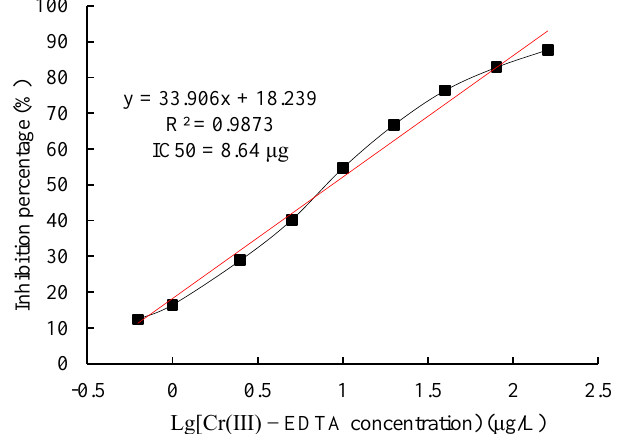
Figure 9. The standard curve of an icELISA for Cr( Ш ) － EDTA. The standard curve was obtained using icELISA optimized conditions for Cr( Ш ) － EDTA.